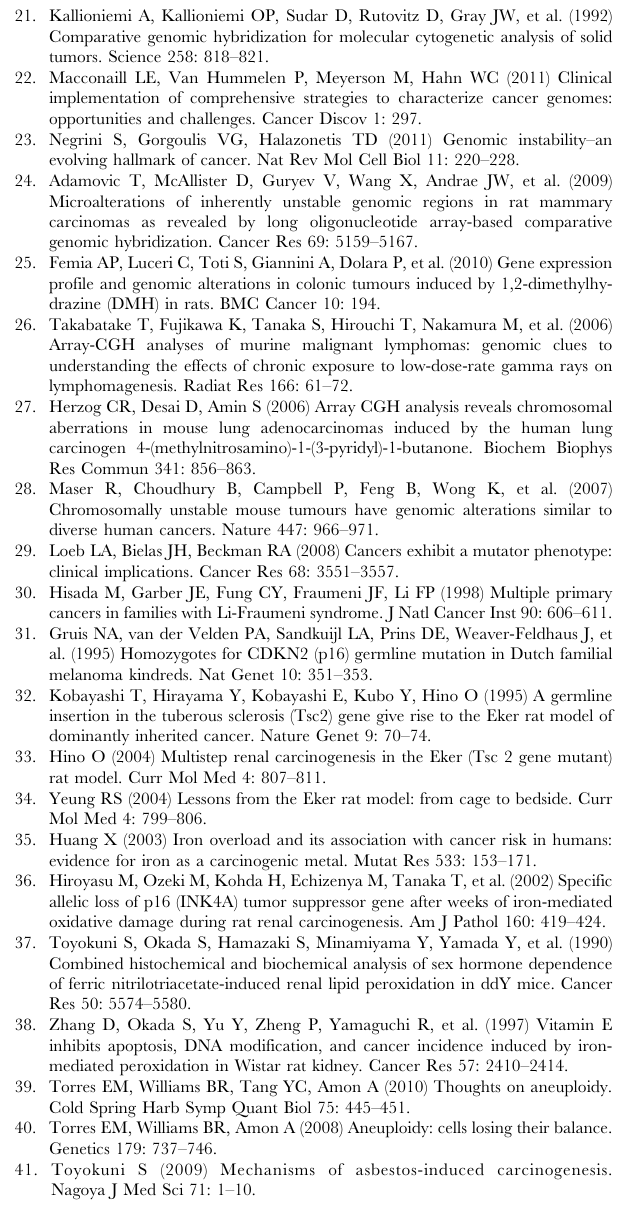
Table S2 List of genes amplified in more than two RCC tumors. Methods S1 Supplementary